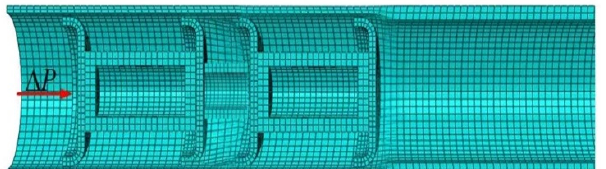
Figure 3. Finite element model of the two-section pipeline robot.